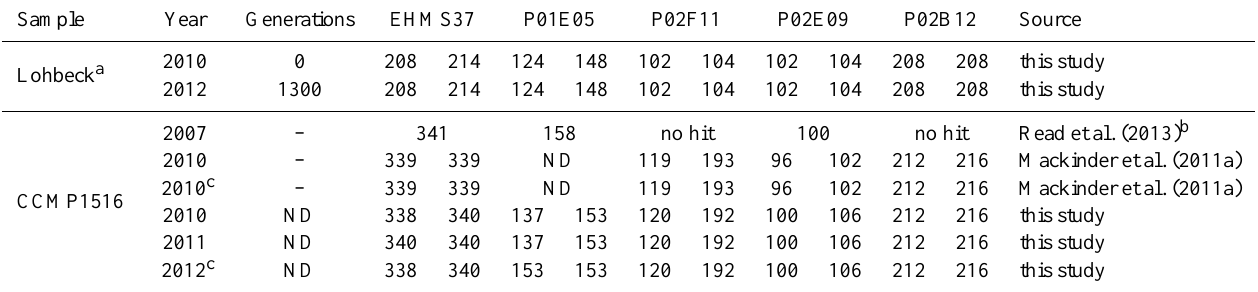
Table 4. Microsatellite stability over multiple generations. Sample